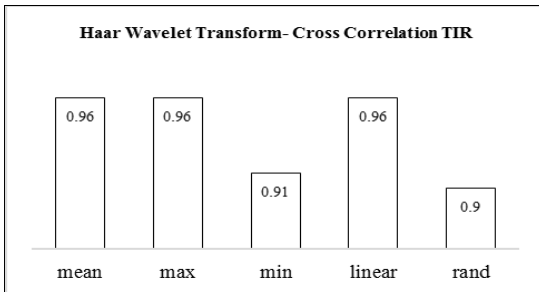
Figure 11. Cross correlation with